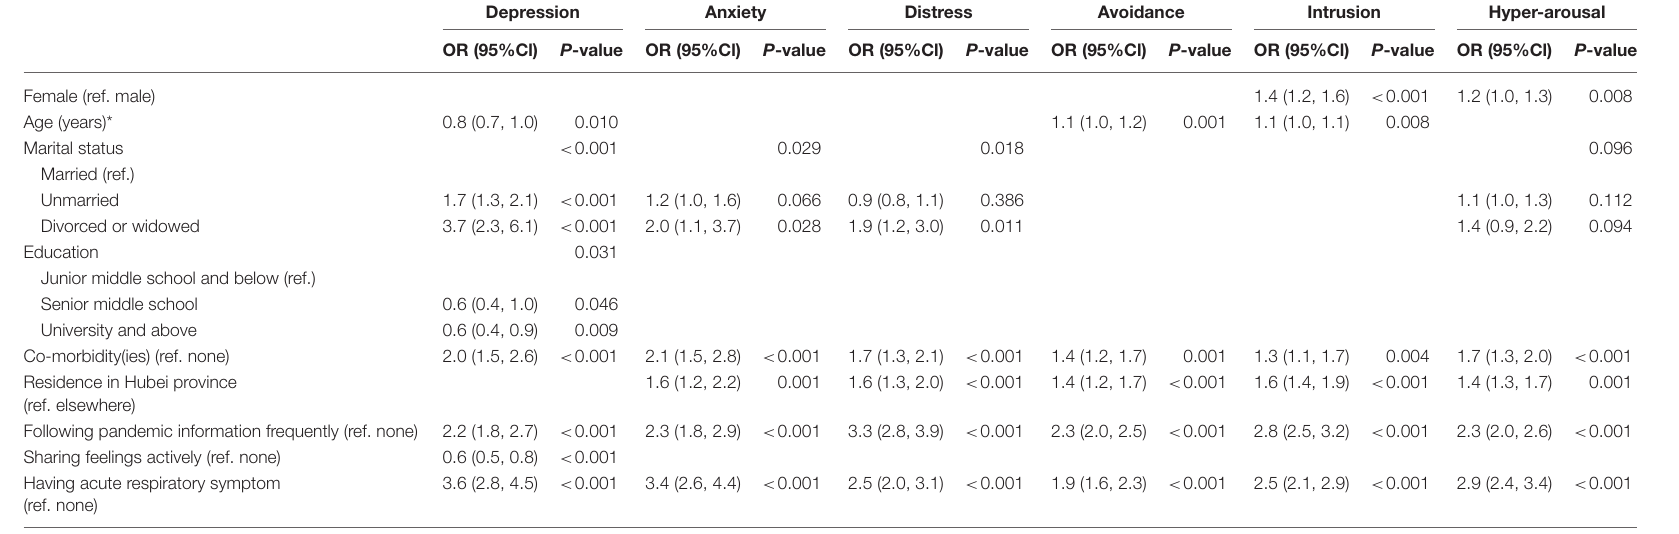
TABLE 5 | Multivariate analyses of mental health of controls. Depression Anxiety Distress Avoidance Intrusion Hyper-arousal